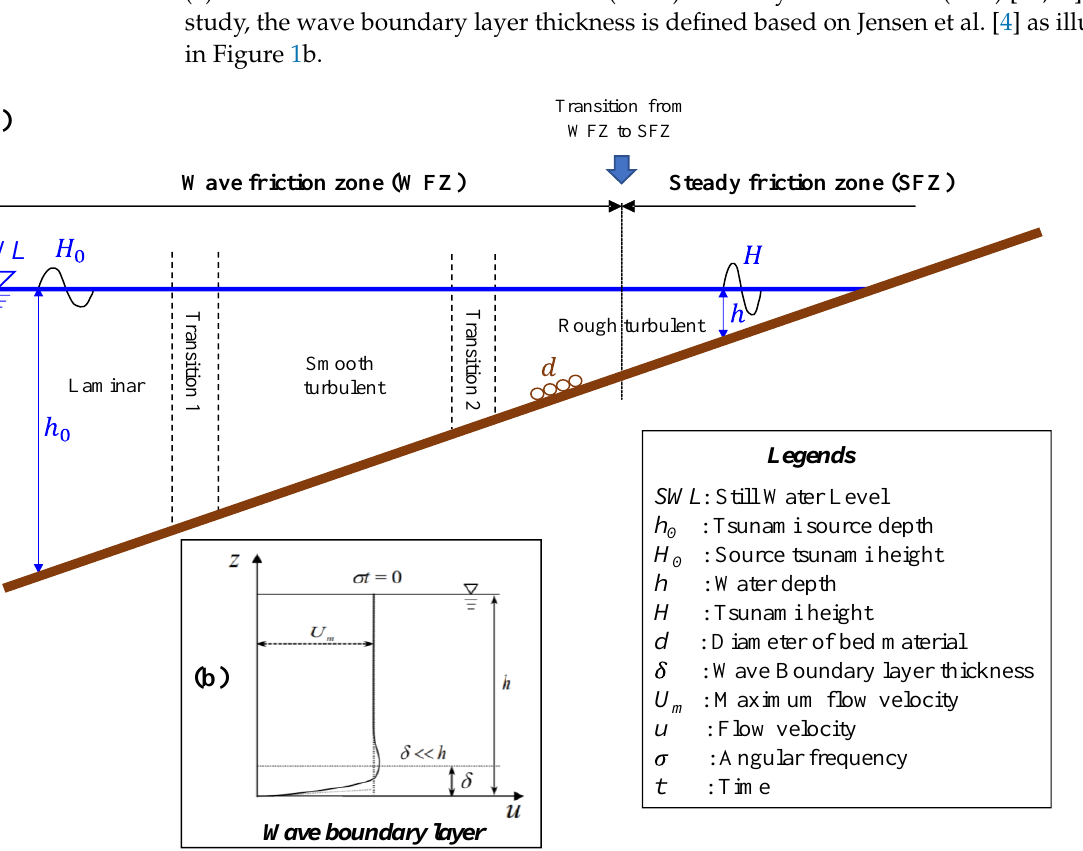
Figure 1. (a) Transitions of bottom boundary layer under tsunami, (b) Wave boundary layer thick- Figure 1. ( a ) Transitions of bottom boundary layer under tsunami, ( b ) Wave boundary layer thickness ness (modified from [20]). (modified from